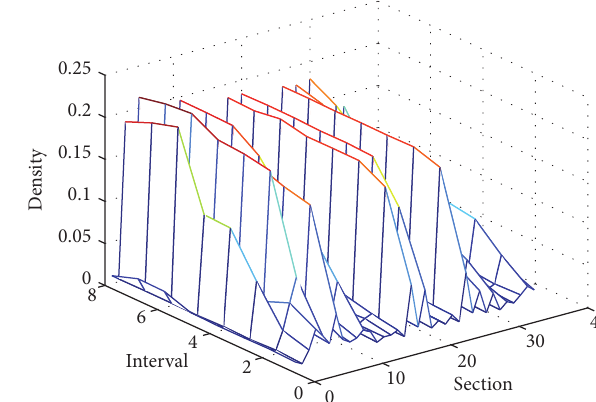
Figure 7: Averaged flow before optimization.